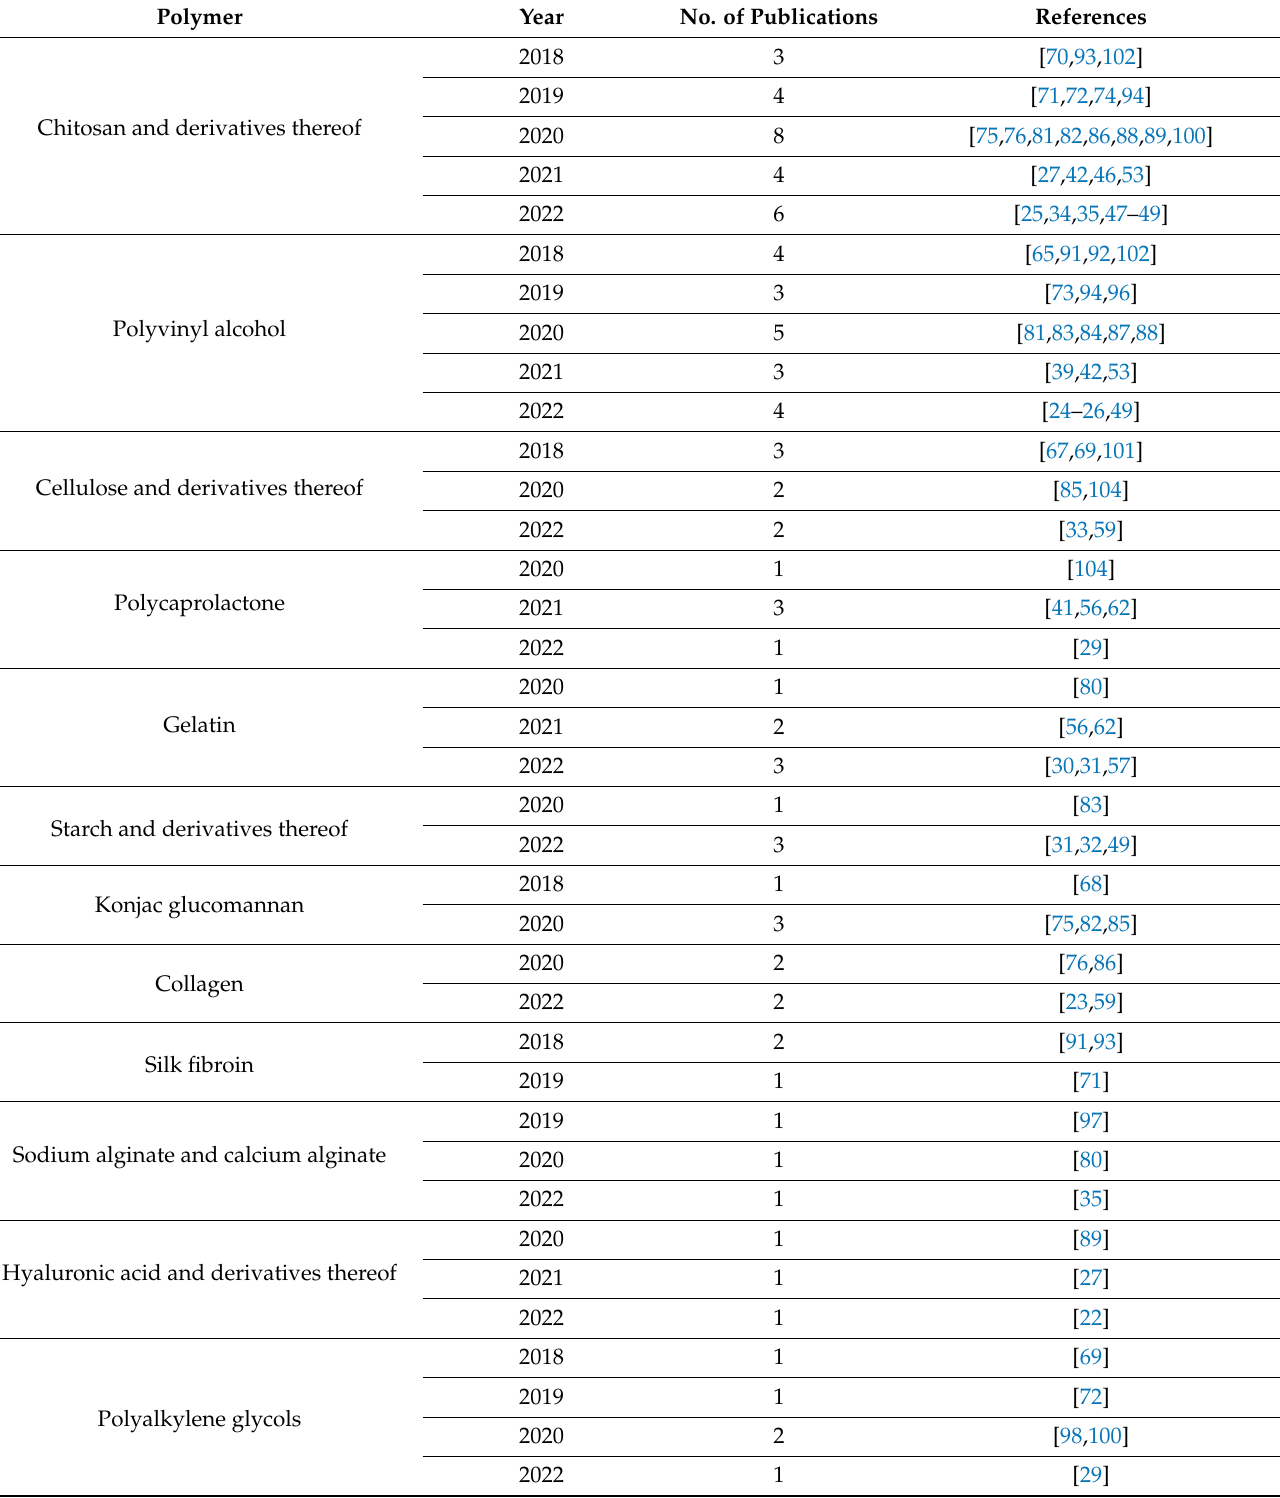
Table 6. The application trends for polymers in the preparation of antimicrobial wound